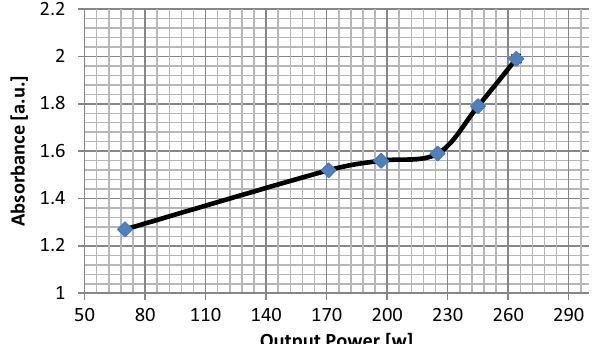
Figure 5. Measurement of the UV–visible absorbance versus power variation for the graphene samples.